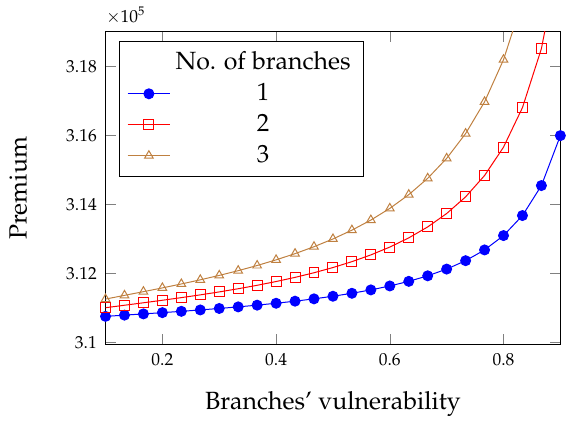
Figure 9. Premium paid by the headquarters in the limited liability